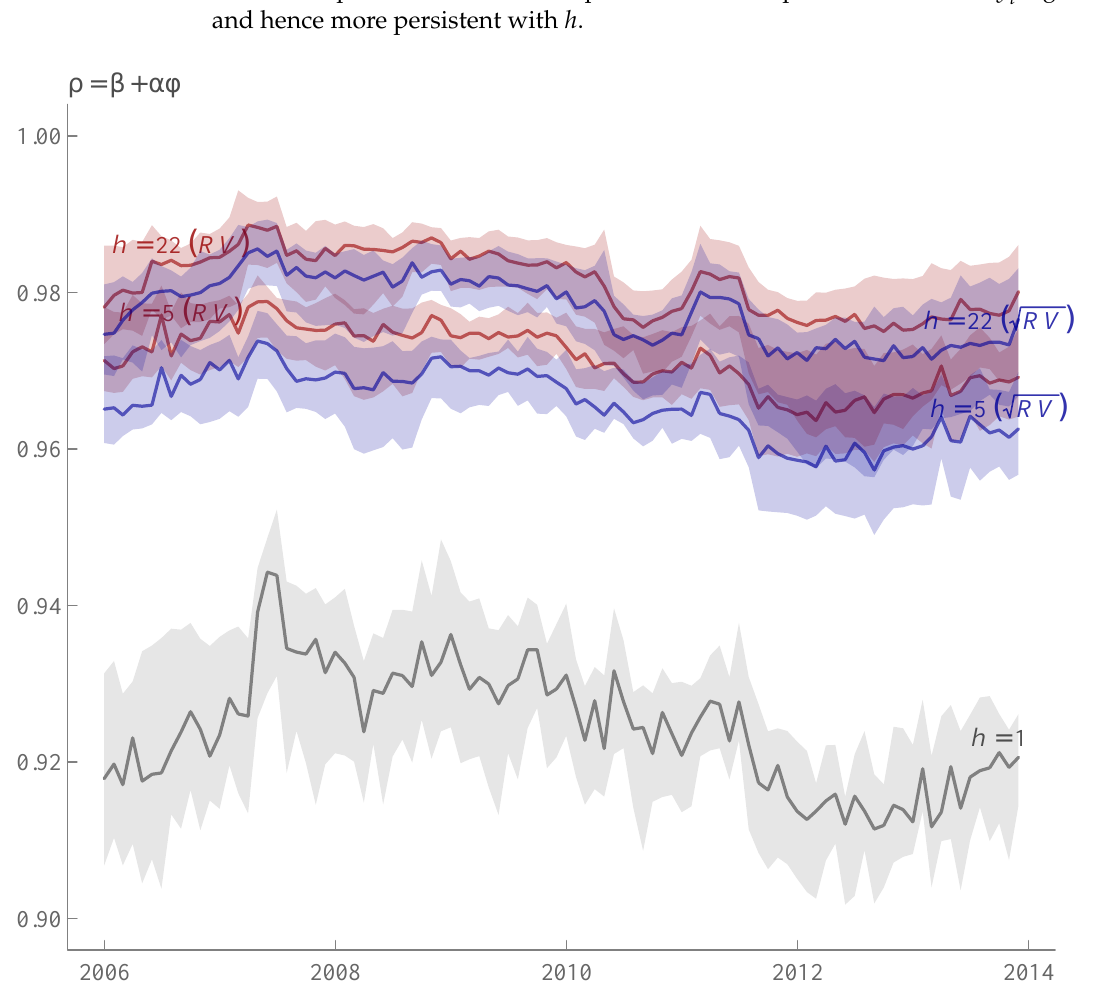
Figure 2. Rolling estimates of the implied persistence parameter ρ for different stepsize h . For h > 1, two models are estimated: one using the log of the average of RV (red) and one with the log of √ RV (blue). The shaded area is the interquartile range across the 27 stocks and the the average of solid line is the median. The daily sample is from 22 April 1997 to 31 December 2013 (4200 trading days). The rolling estimation window is 8.67 years (104 months) followed by a one-month prediction window shifted each month over the sample for 96